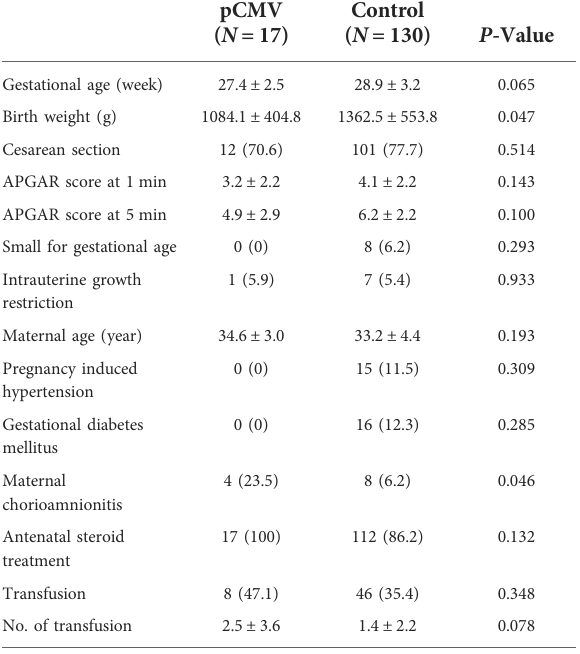
TABLE 1 Demographic fi ndings of the postnatal cytomegalovirus infection and control